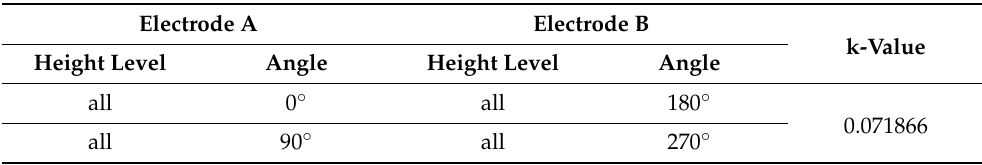
Table A1. Geometry factors k for the drilling core analysis, calculated by Comsol with an electrode array with angular distances of 90 ◦ and electrical conductivity of the electrodes in Comsol model of stainless steel: 1.4 × 10 6